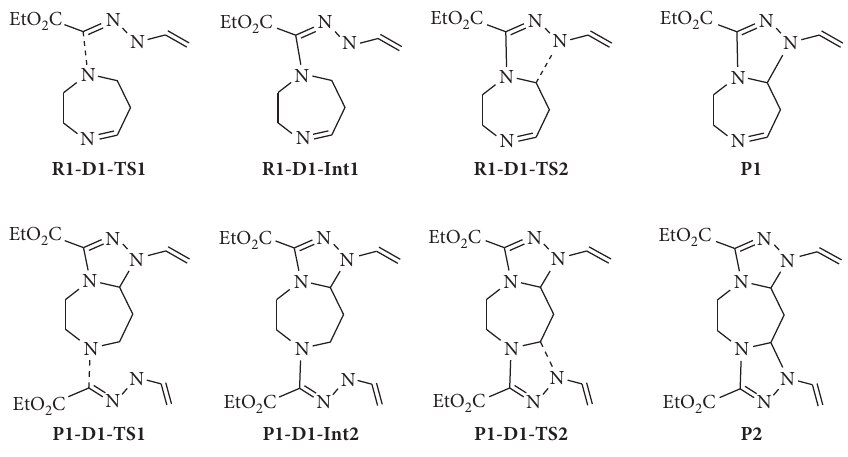
Figure 3: Species involved in the cycloaddition reaction (see Scheme 2 and Table